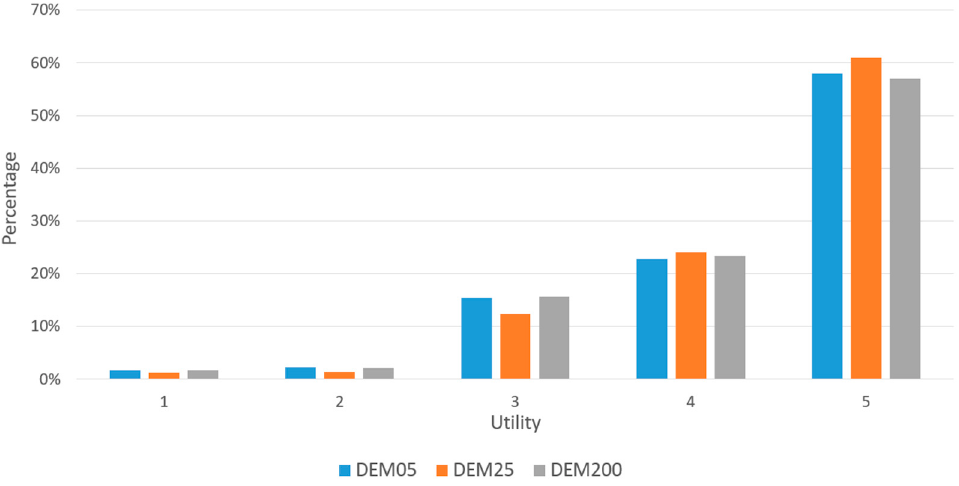
Figure 11. Percentage of utility levels in each type of DEM.